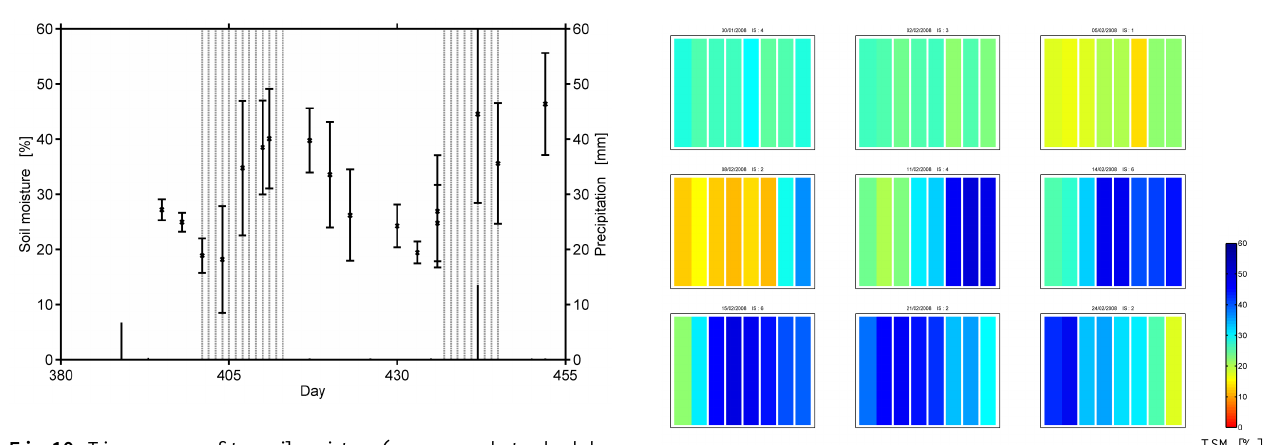
Fig. 10. Time course of topsoil moisture (average and standard de- Figure 10.  Time course of topsoil moisture (average and standard deviation) retrieved on field 5 viation) retrieved on field 5 together with the irrigation periods (ver- together with the irrigation periods (vertical dotted gray lines) and precipitation (black line at the tical dotted gray lines) and precipitation (black line at the bottom of bottom of the y-axis). The days are numbered from January 1 st , 2007. the y-axis). The days are numbered from 1 January 2007.